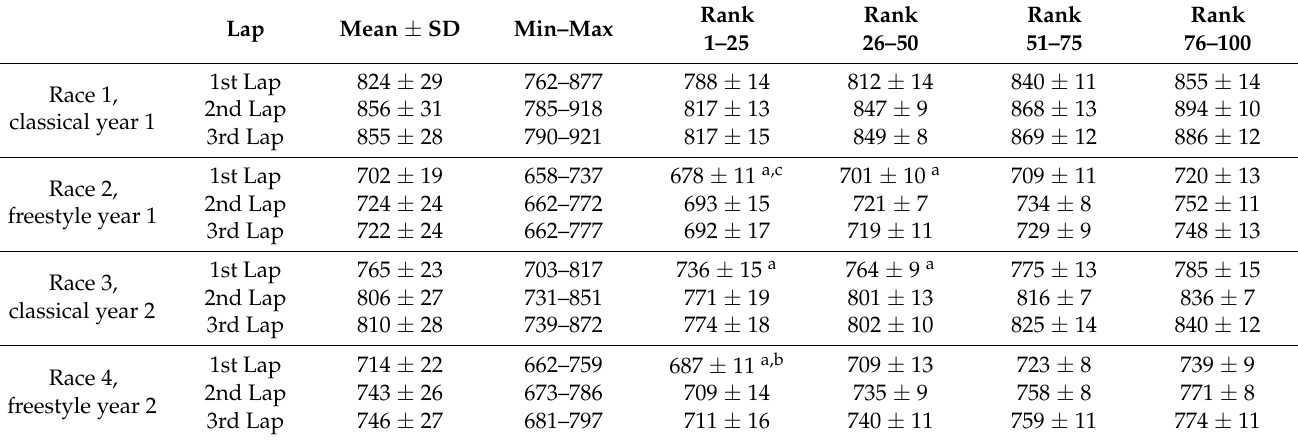
Figure 2. The mean speed changes between 1st versus 2nd and 3rd laps for the different groups among the 100 best in the final rank in four different cross-country competitions: Race 1, year 1 classical; Race 2, year 1 freestyle; Race 3, year 2 classical; Race 4, year 2 freestyle. Percentage speed changes are calculated as percentage increase/decrease in lap time for an average of the 2nd and 3rd lap, compared to that of the 1st lap. Table 1. Presentation of lap times (seconds) for the top 100 fastest cross-country finishers in the four 15 km individual time trial races from the Norwegian national season opening races in Beitostølen in year 1 and year 2. a = significantly lower mean speed changes between 1st versus 2nd and 3rd laps than in the group ranked 76th–100th place ( p < 0.05), b = significantly lower mean speed changes between 1st versus 2nd and 3rd laps than in the group ranked 51st–76th place ( p < 0.05), c = trend towards lower mean speed changes between 1st versus 2nd and 3rd laps than in the group ranked 51st–75th place ( p <